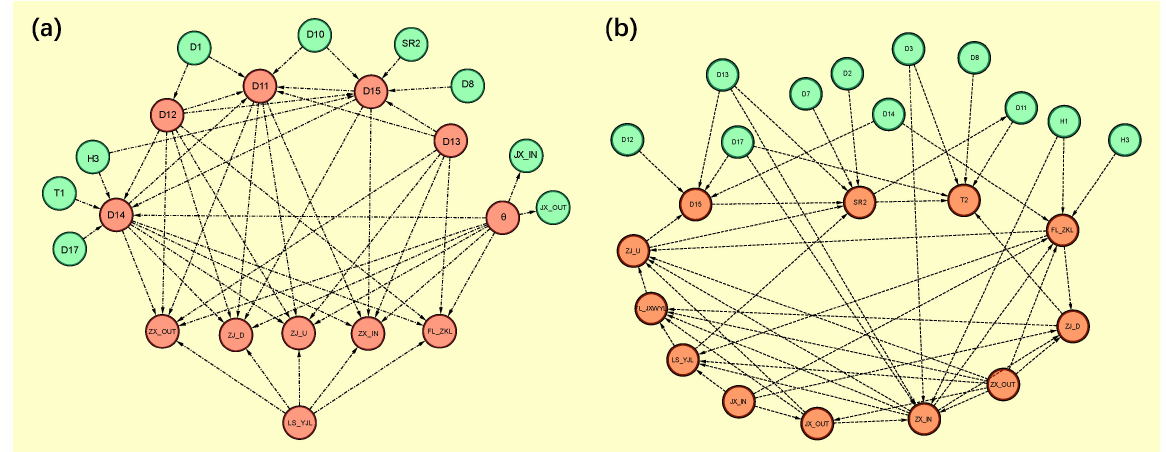
Figure 4. Bayesian network structures are learned by two different methods. According to (15), the nodes/variables are marked in orange, if ki > 4. ( a ) The Bayesian network is learned by the iBWL method. ( b ) The Bayesian network is learned by the regular BIC learning